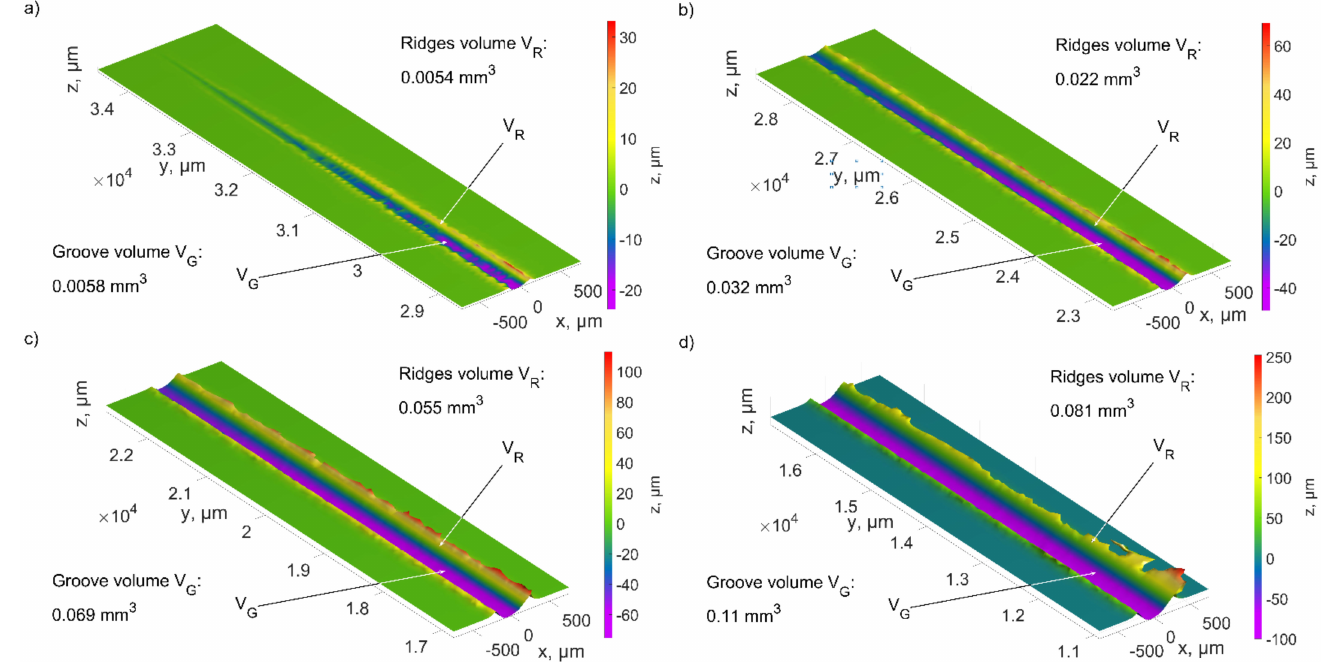
Figure 13. The values of the scratch volume and pile ups after the ZS1 grain cutting process for the depth of cut: ( a ) from 0 to 25 µ m, ( b ) from 25 µ m to 50 µ m, ( c ) from 50 µ m to 75 µ m, ( d ) 75 µ m to 100 µ m.